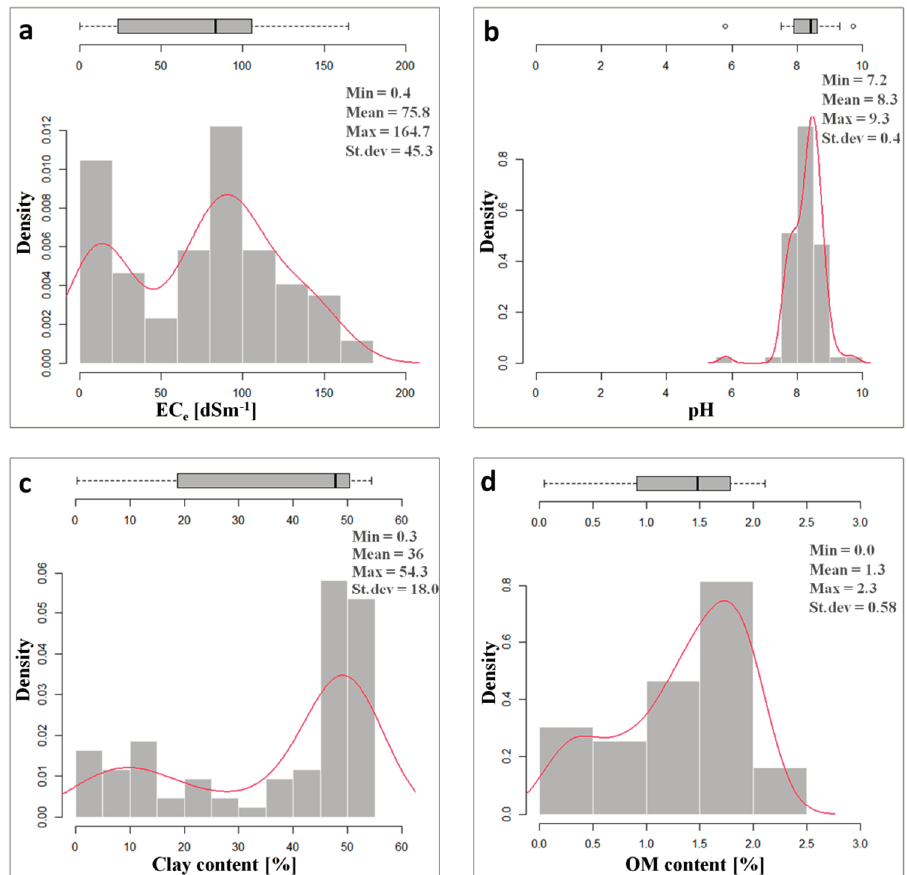
Figure 2. Density plots and outlier box-plots of soil properties. ( a ) EC e , ( b ) pH, ( c ) Clay content, ( d ) OM